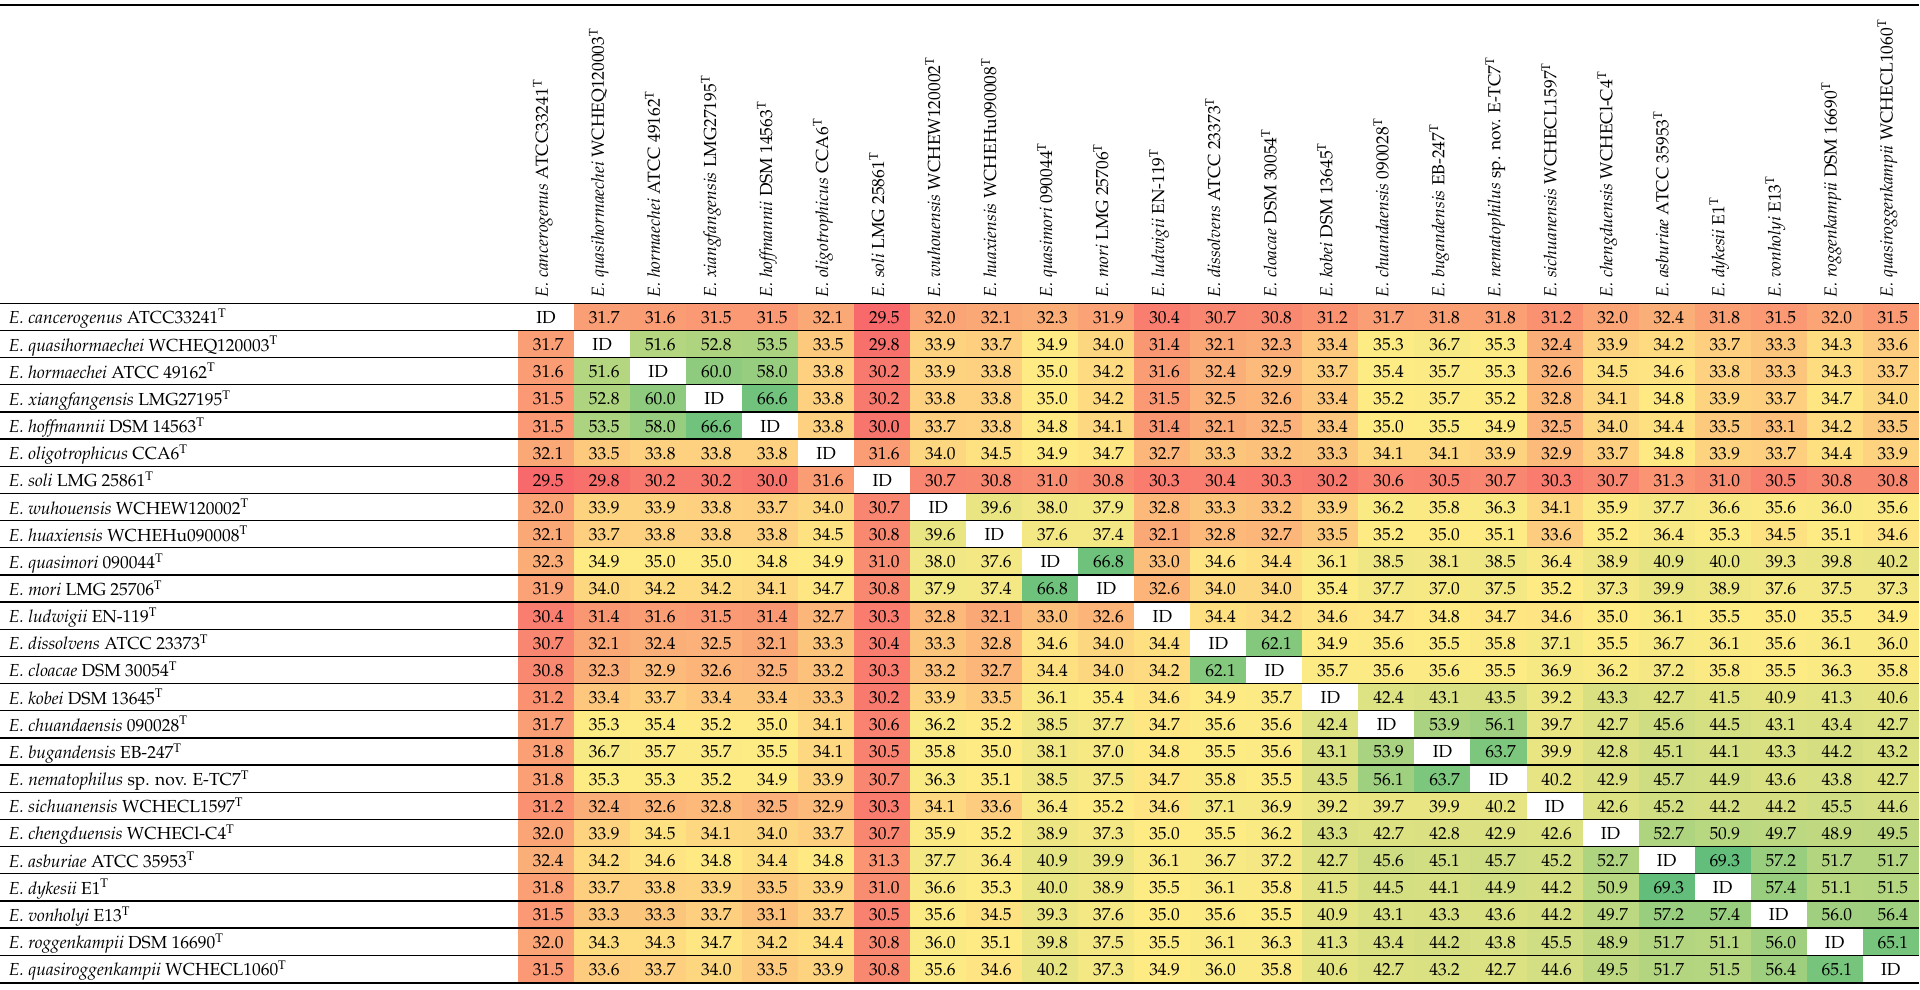
Table 3. Pairwise comparison of digital DNA-DNA Hybridization (dDDH) scores (%) of all the species of the genus Enterobacter . Accession numbers of the sequences used in the analyses are shown in Table S1. Colors indicate the degree of relatedness between bacterial species